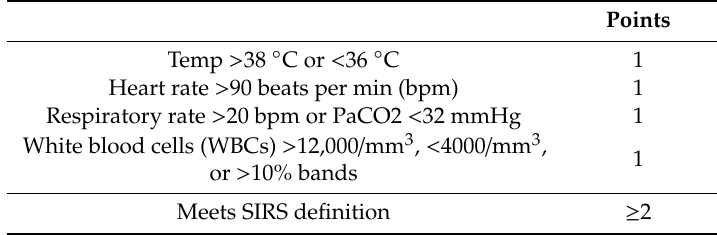
Table 1. Systemic inflammatory response syndrome (SIRS) score.